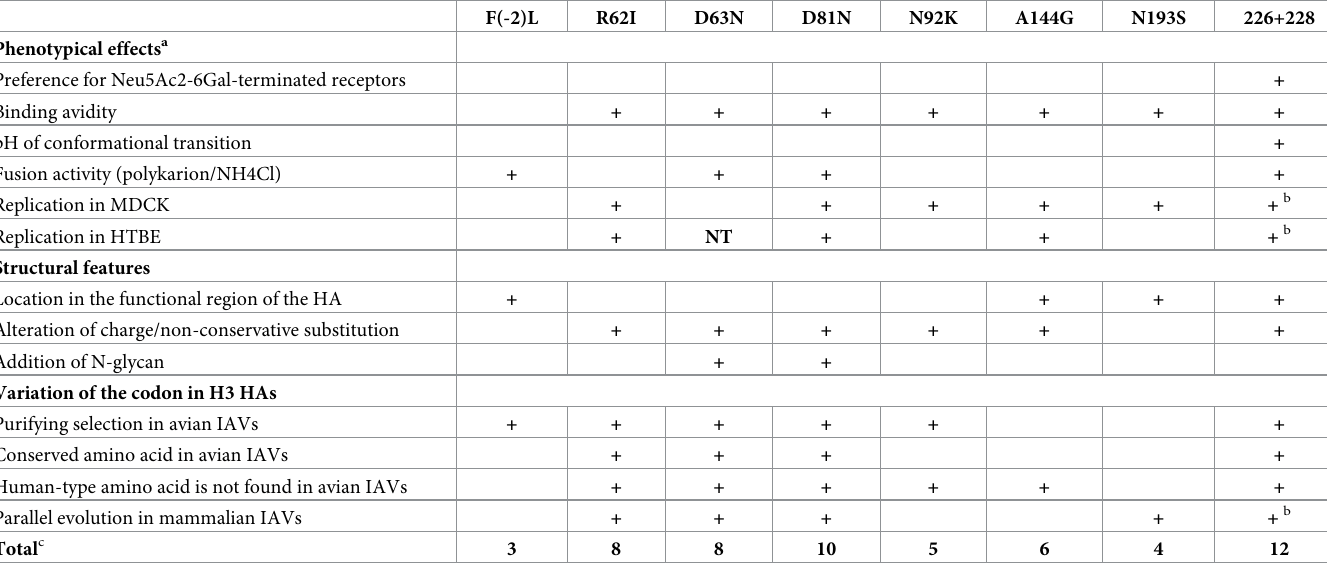
Table 3. Characteristics of avian-to-human amino acid substitutions in pandemic H3N2/1968